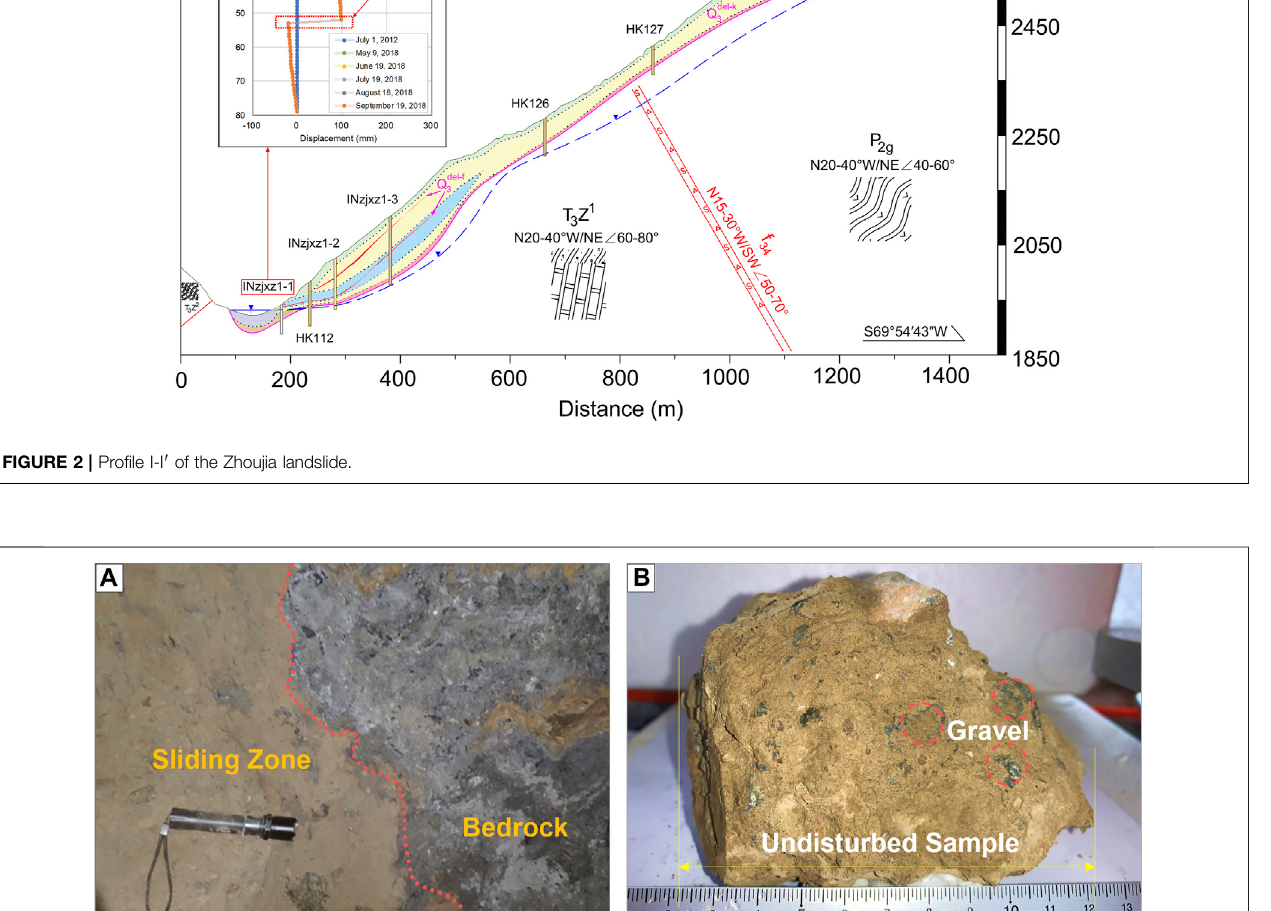
Frontiers in Earth Science |